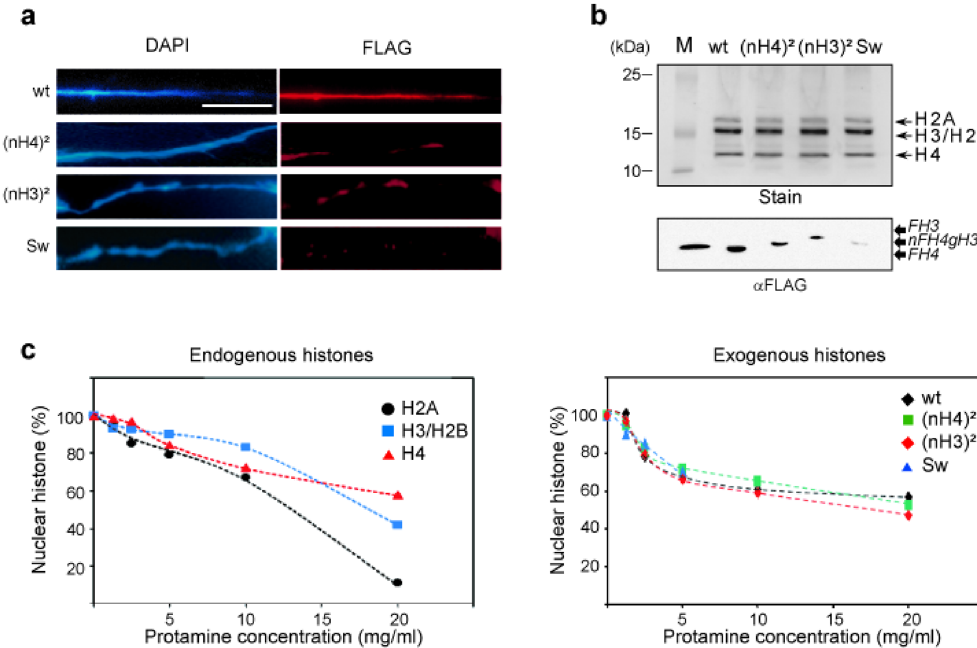
Figure 4. Chromatin assembly in the S-phase occurs regardless of histone tail positioning. ( a ) Microscopic distribution mapping of exogenous H3/H4 complexes. Following exogenous H3/H4 incorporation, nuclei were prepared, chromatin was combed, immuno-stained with anti-FLAG (FLAG) and counterstained with DAPI (DAPI). The chromatin fibers were imaged by fluorescent microscopy. ( b ) Exogenous H3/H4 complexes assembled in nucleosomes. Following incorporation, nucleosomes were isolated from nuclei by MNase digestion and sucrose gradient. Nucleosomal proteins were analyzed by SDS-PAGE (Stain) and Western blotting revealed with anti-FLAG antibody ( α FLAG). Lane M corresponds to the molecular weight marker in (Stain) and the purified H3/FH4 complex revealed by anti-FLAG antibody in ( α FLAG). ( c ) Histone stability in chromatin. Protamine competition assays were performed on nuclei and analyzed by SDS-PAGE (Endogenous histones) and Western blotting (Exogenous histones),